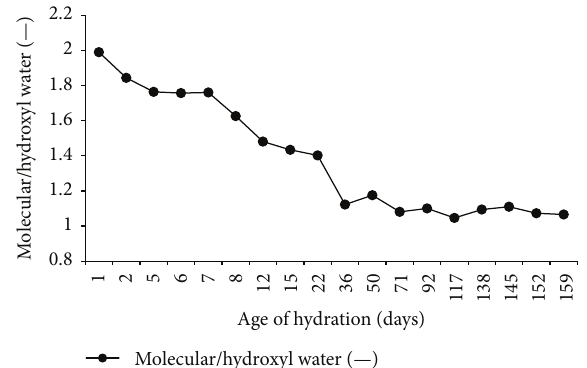
Figure 9: Molecular water to hydroxyl water ratio of hydrated ye’elimite clinker exposed to environment of saturated water